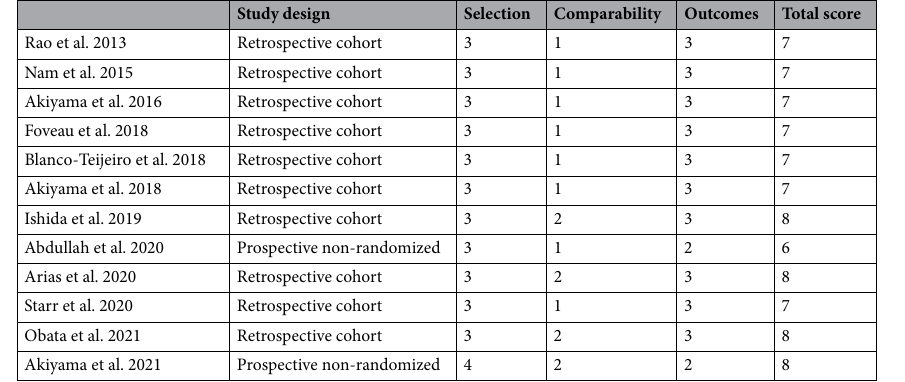
Table 2. Newcastle–Ottawa scale for risk of bias